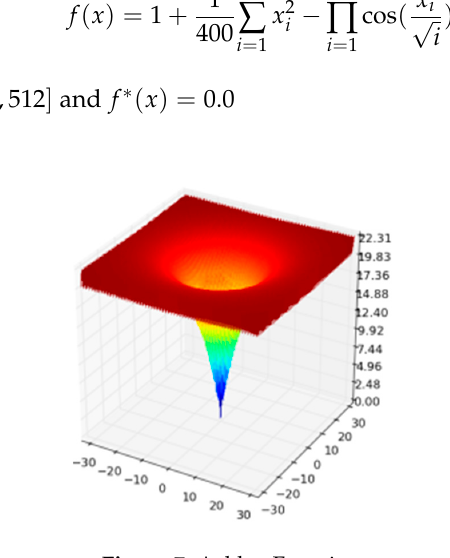
Figure 7. Ackley Function. Figure 7. Ackley